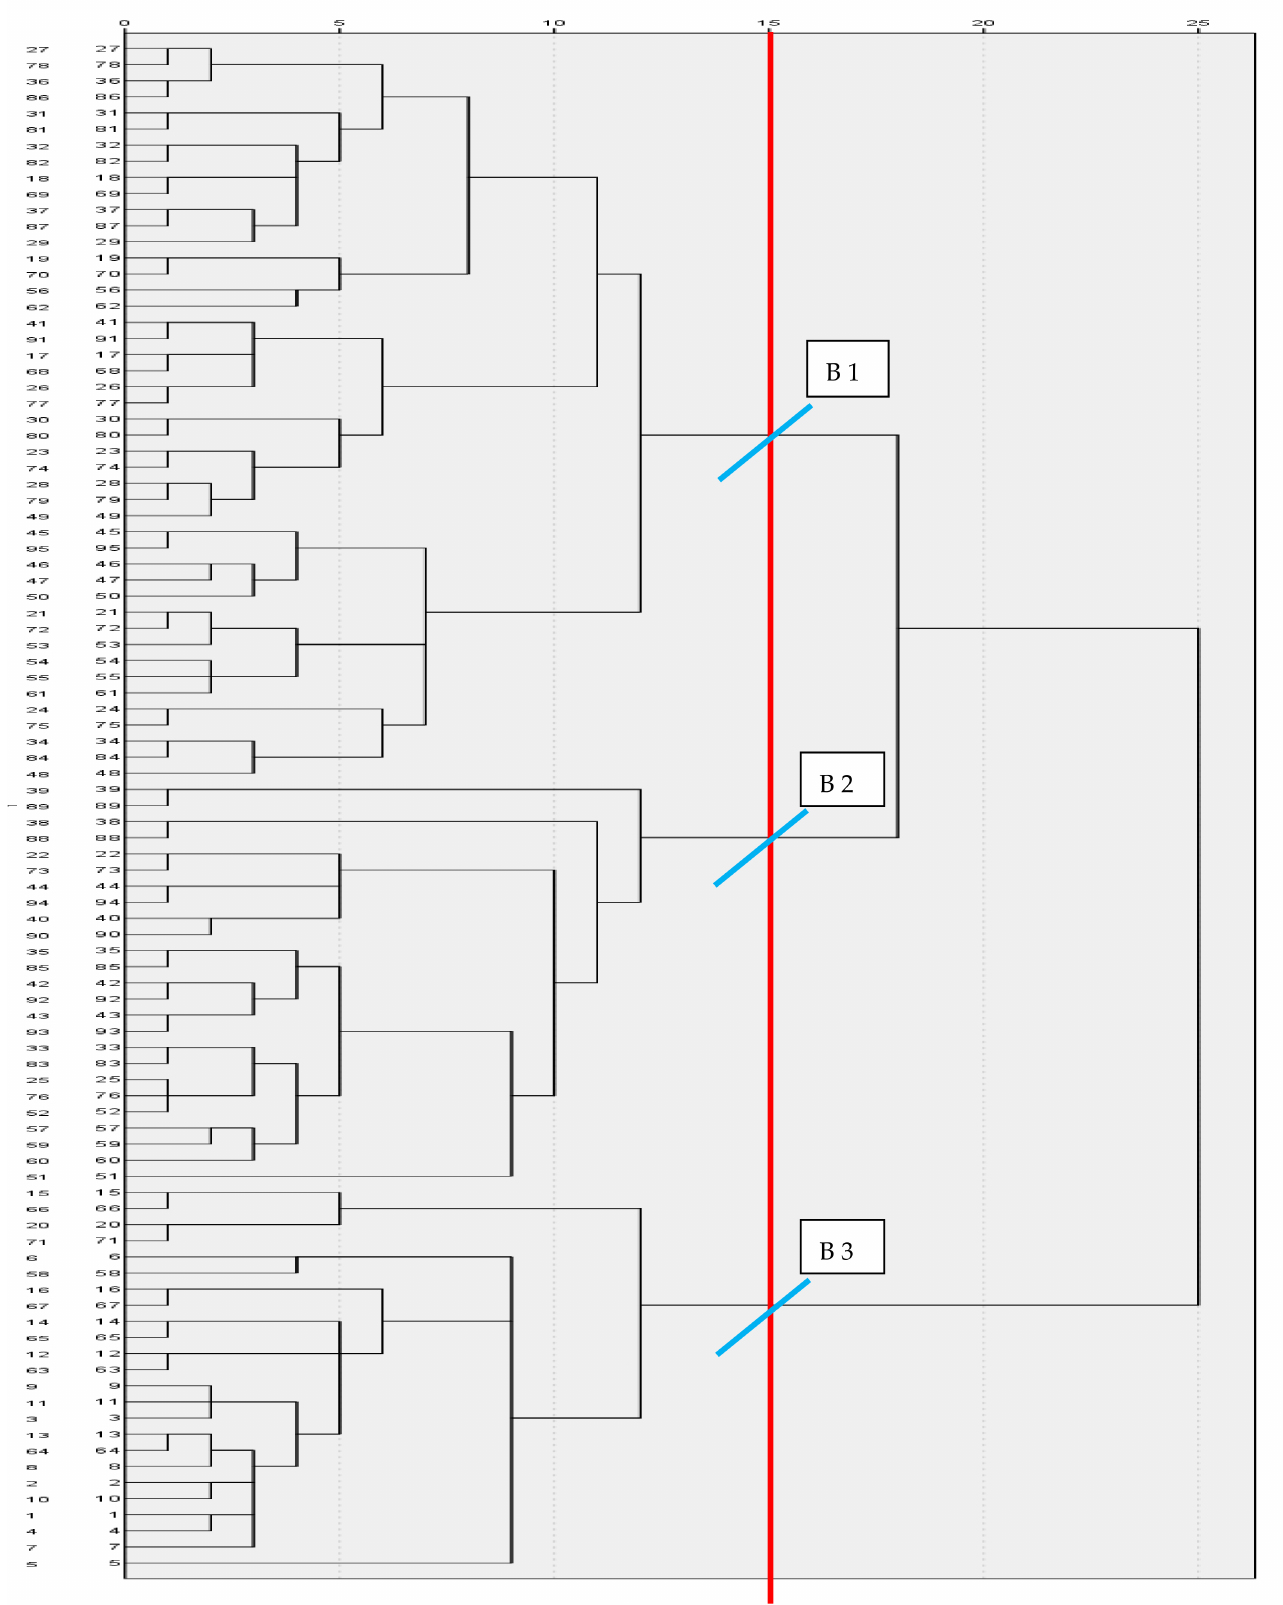
Figure 2. Dendrogram that uses the Ward method. Re-scaled distance cluster